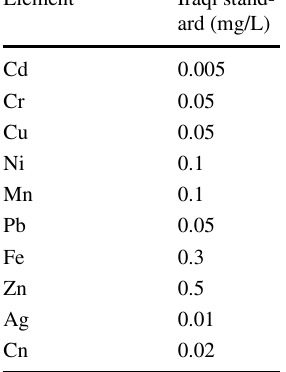
Table 3 Iraqi stream standard for heavy metals (Ministry of Environment 2001)